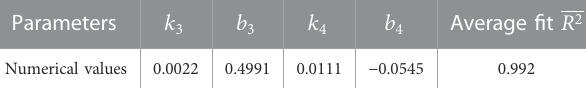
TABLE 7 Parameter fi tting values of Cheng ’ s linear